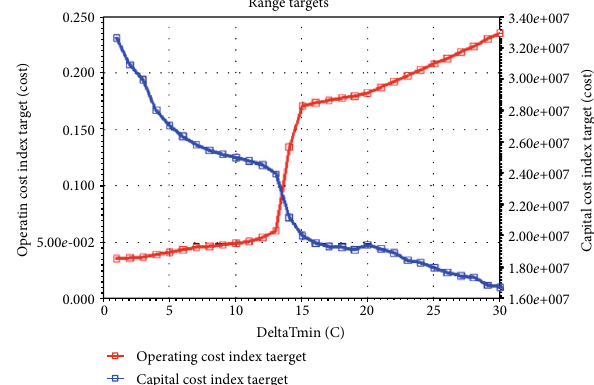
Figure 5: Minimum temperature di ff erence diagram of heat